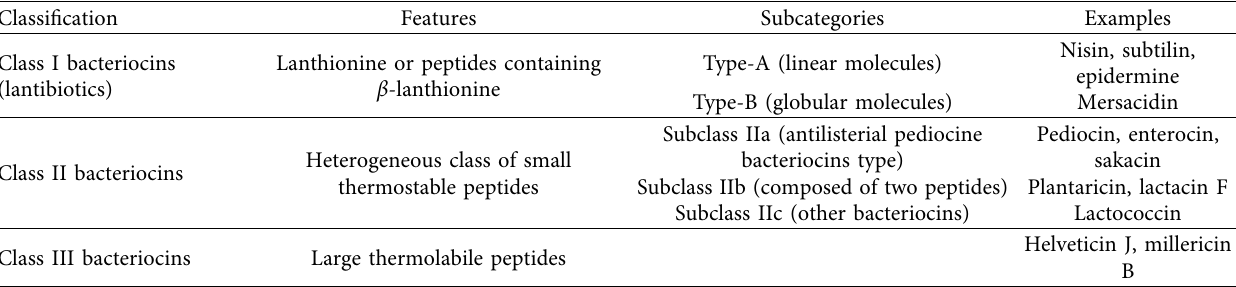
Table 1: Classification of bacteriocins adapted from